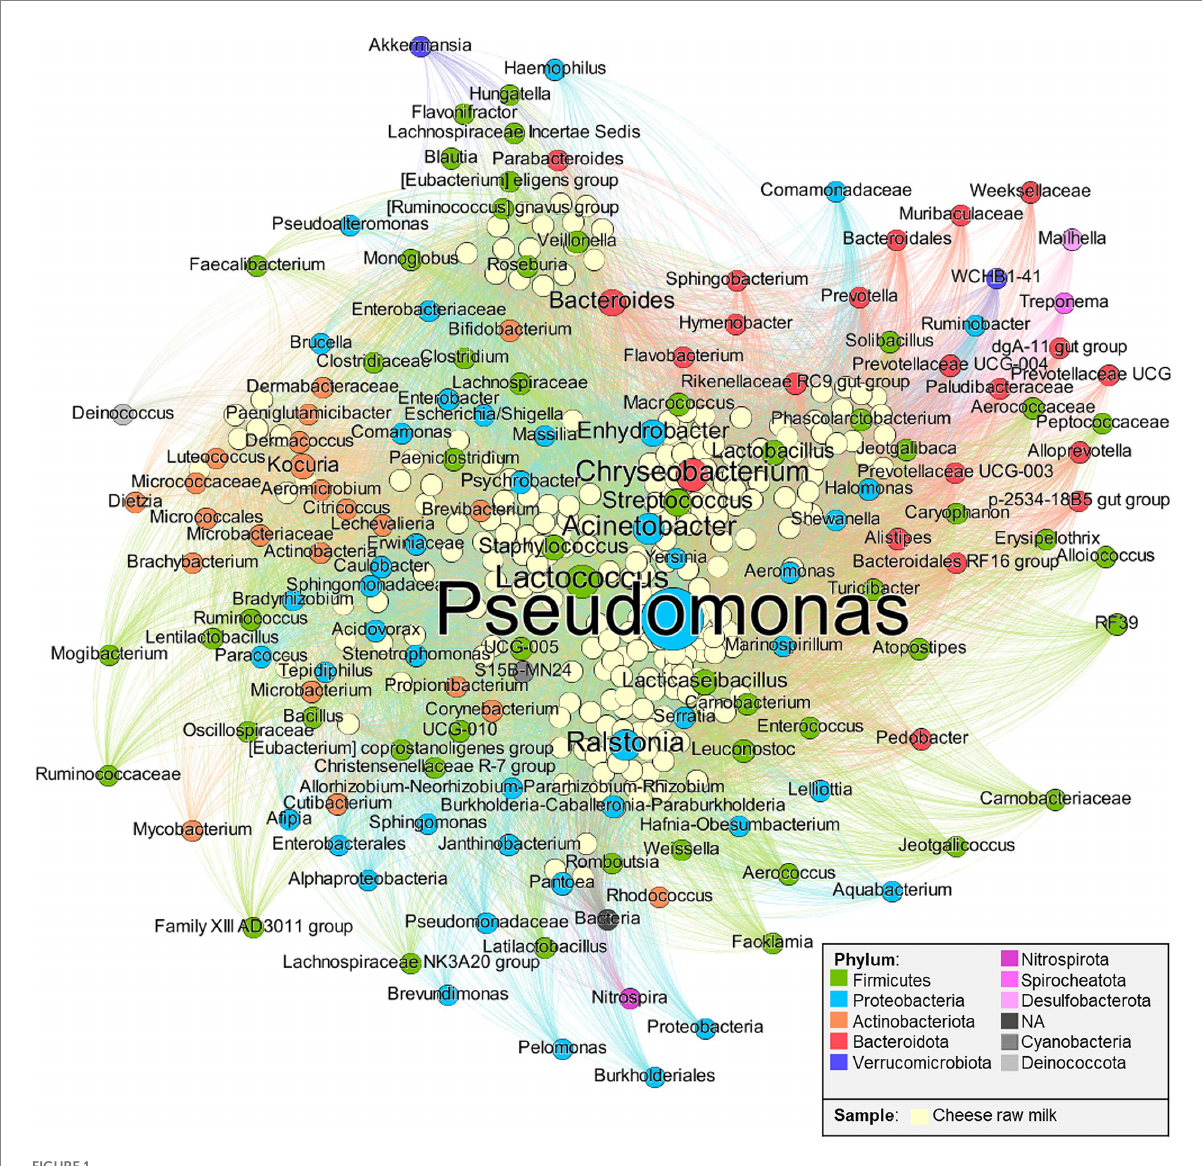
FIGURE 1 Bipartite network. Nodes represent cheese raw milk samples and Operational Taxonomic units (OTUs), linked to each other by edges. OTUs’ label and node size are directly proportional to their relative abundance in all the raw milk samples. Data were extracted from studies listed in Supplementary Table